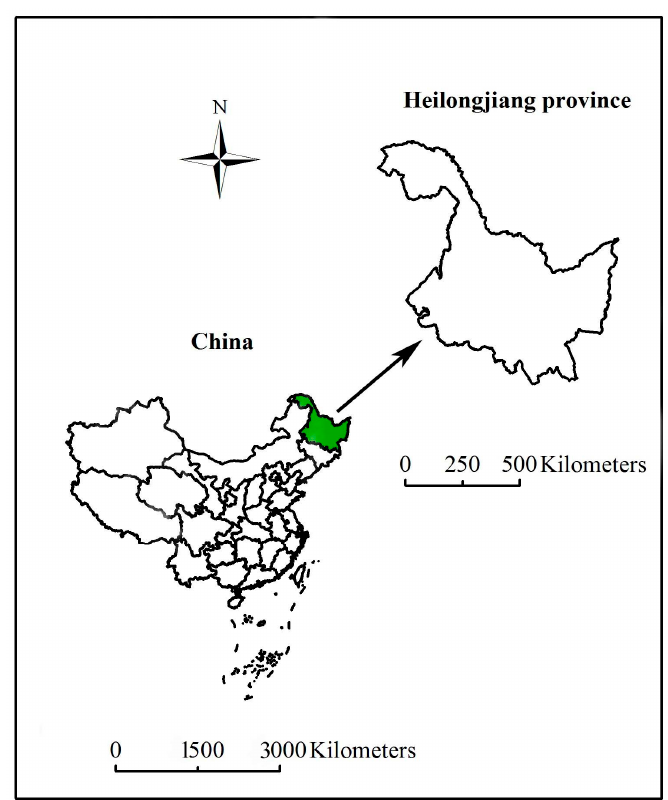
Figure 1. Map of the study area in Heilongjiang Province, China.